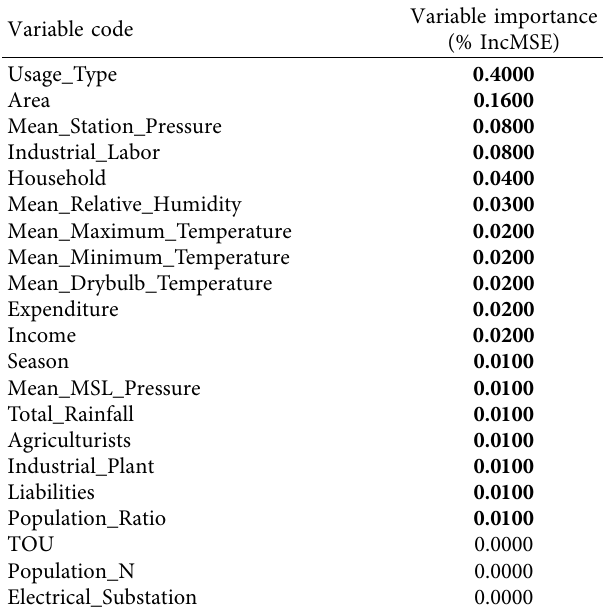
Table 5: Feature importance based on the RF